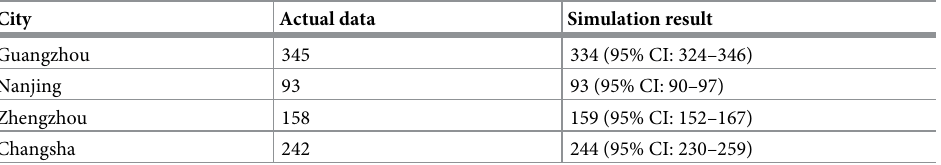
Table 2. The peak of cumulative number of infected persons in the four cities of China: Guangzhou, Nanjing, Zhengzhou and Changsha.